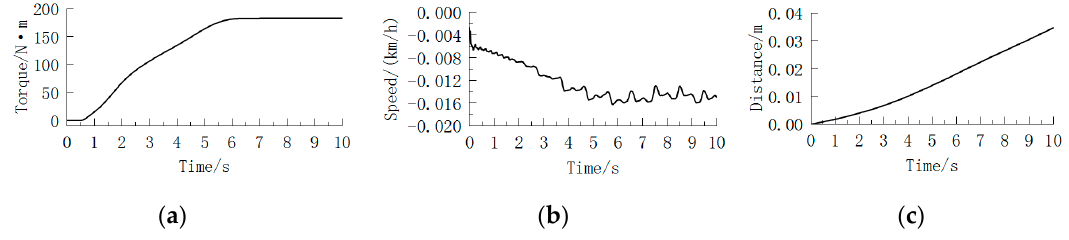
Figure 15. Control Process of 38% Inclination Condition: ( a ) Curve of Motor Output Torque; ( b ) Curve of Vehicle Velocity; ( c ) Curve of Rollback Distance.